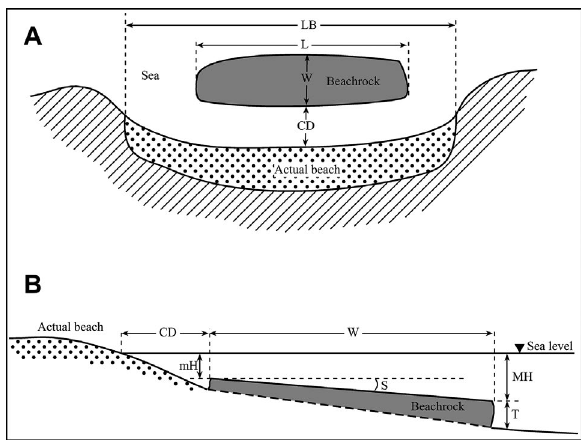
Fig. 2. – Main morphometric features of beachrocks. A, plan view: LB, length of the current beach. L, beachrock length. W, beachrock width. CD, coastal distance. B, cross section: CD, coastal distance. W, beachrock width. mH, minimum depth. MH, maximum depth. T, thickness. S,